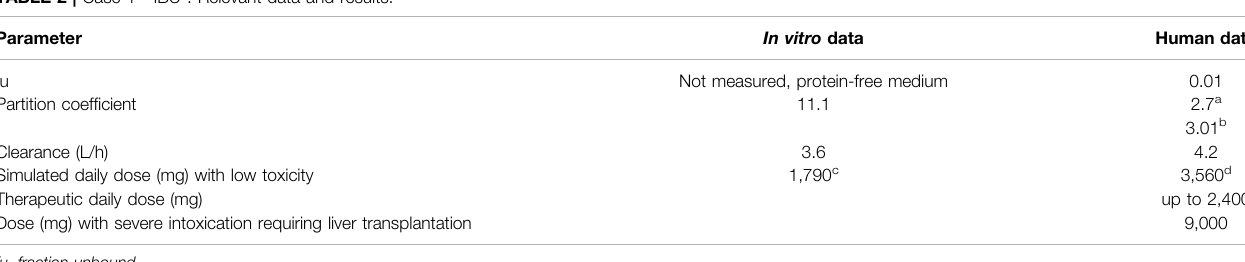
TABLE 2 | Case 1 — IBU-: Relevant data and results. Parameter In vitro